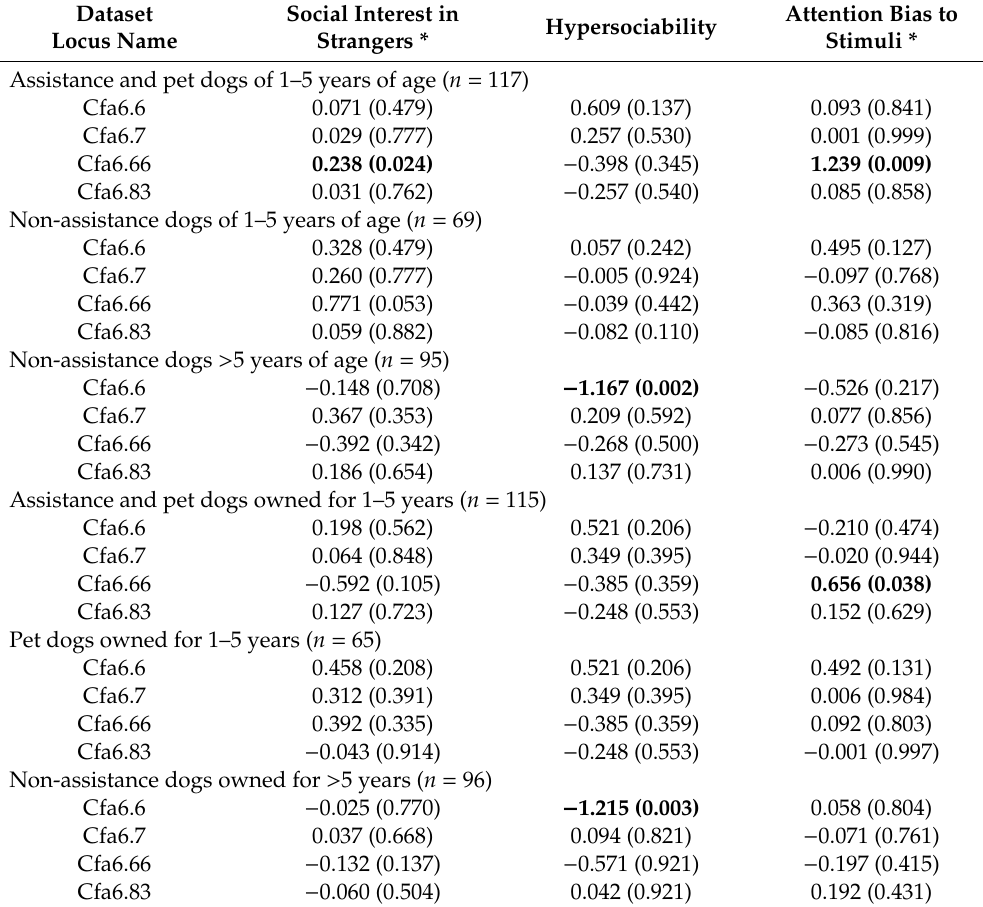
Table 1. Per locus beta values as a function of MEI copy number and C-BARQ © score averages that quantify behaviors associated with three aspects of hypersociability as per vonHoldt et al. [22] Significance values are in parentheses (bolded values indicate p <